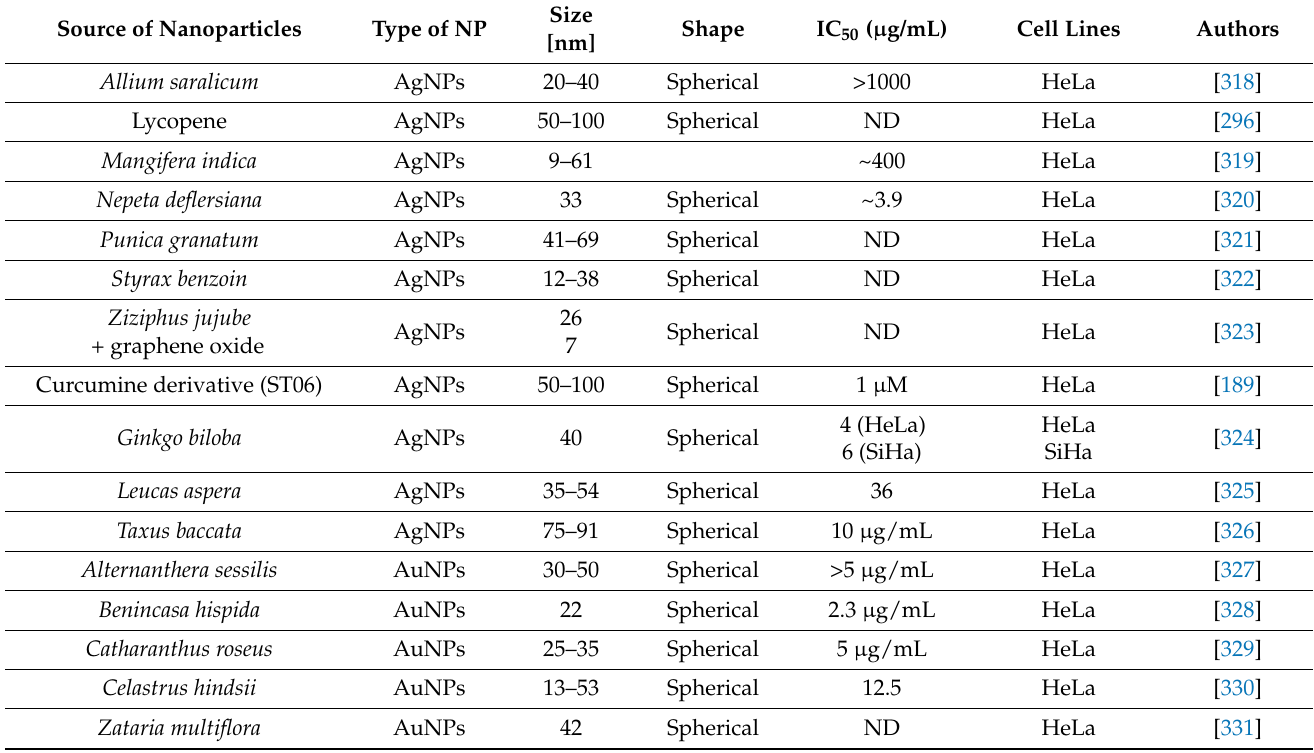
Table 10. Evaluation of green biogenic Au and AgNPs in HeLa and SiHa cells of cervix adenocarcinoma; biological source, NPs characteristics, and IC 50